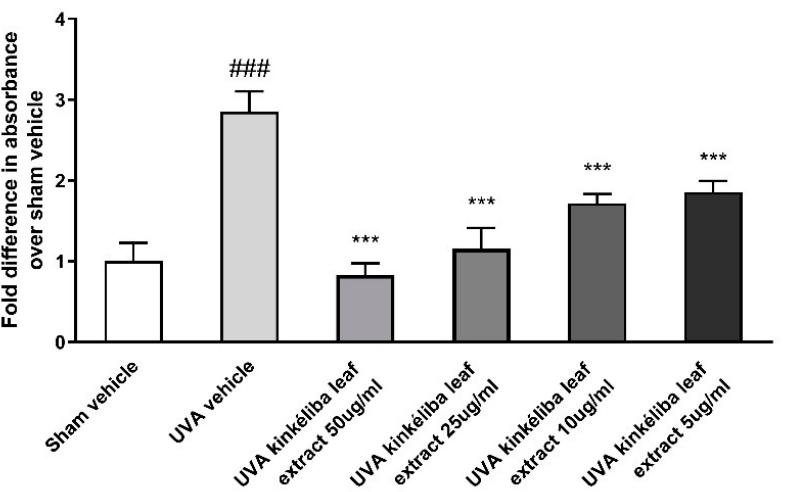
Figure 3. Treatment reduced UVA-induced reactive oxygen species (ROS). Cells were treated with kink é liba leaf extract and cultured for 24 h before UVA irradiation. The formation of ROS was evaluated by means of DCFA. Each value is presented as the mean ± SD from triplicate independent experiments. Significantly different from sham vehicle, ### p < 0.001; UVA vehicle, *** p <